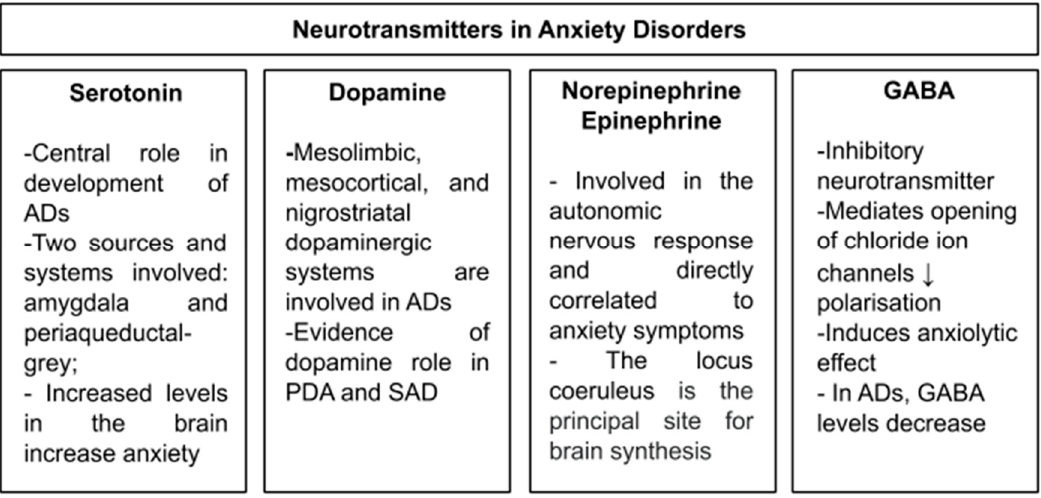
Table 1. Summary of the literature findings related to the neurotransmitters involved in general anxiety disorders (GAD), panic disorders with or without agoraphobia (PDA), and social anxiety disorder (SAD).